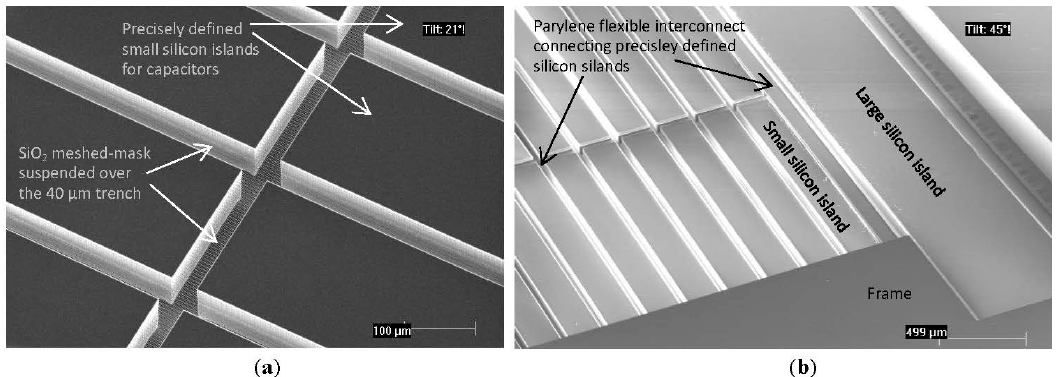
Figure 2. SEM images of the precisely defined 80 µm thick silicon islands: ( a ) Top view of the remaining SiO 2 mesh-shaped mask after the trench front-side DRIE process; ( b ) Bottom view of the final device with separated small and large silicon islands after the back-side two-step DRIE